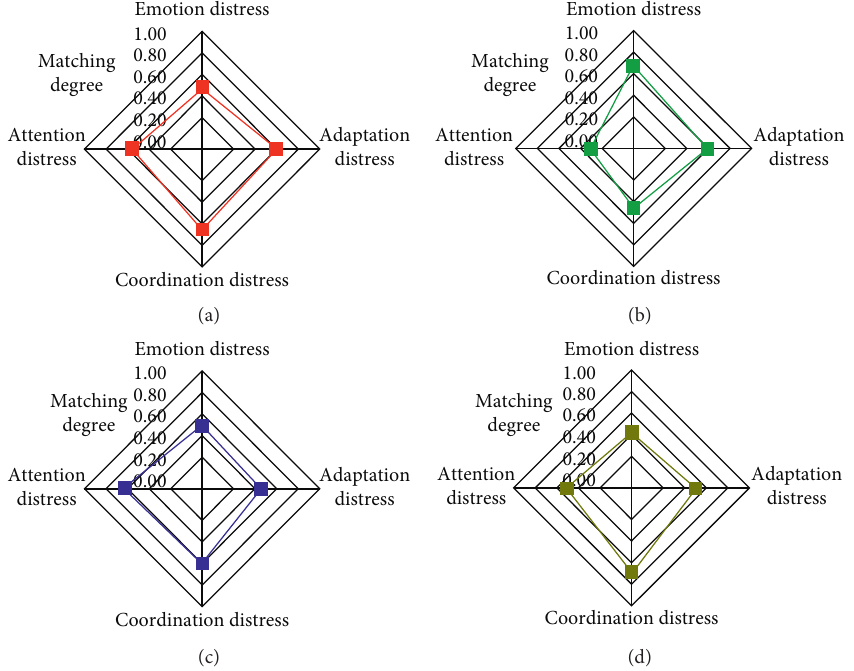
Figure 7: Matching degrees of children’s different psychological distress types in (a) solitary, (b) social, (c) entertainment, and (d) learning scene